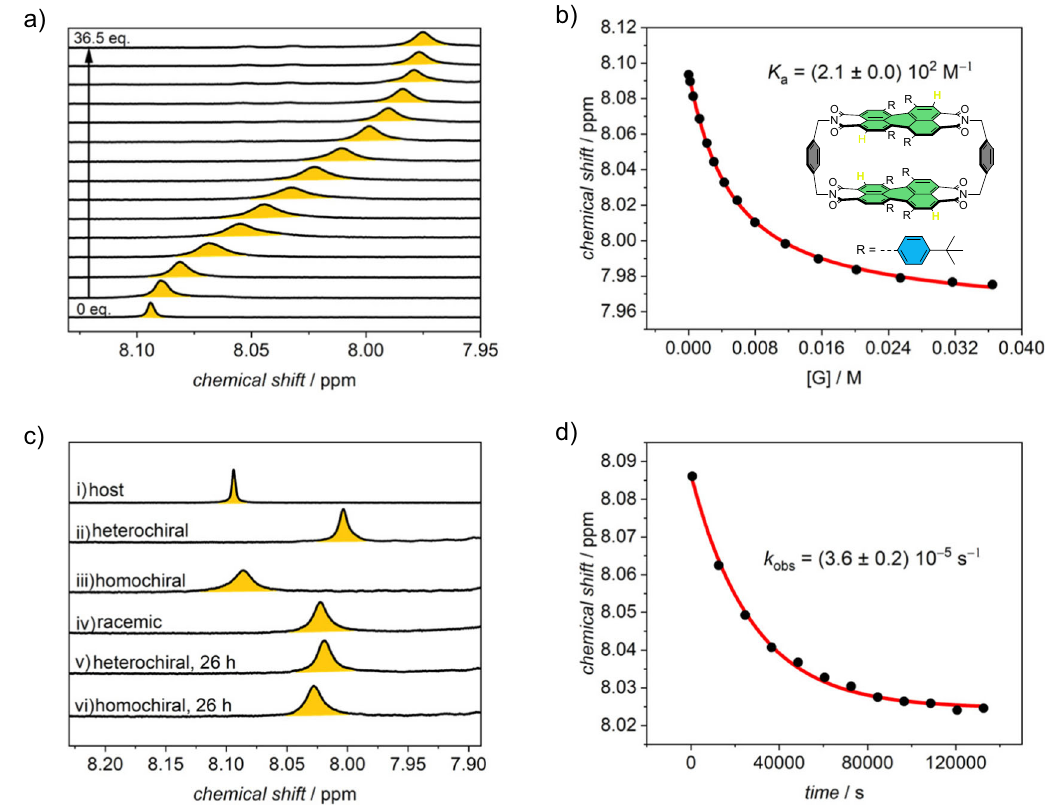
Fig. 4 | Complexation studies with [5]helicene. a Excerpt of 1 H NMR (CCl 4 /MCH- d 14 3:1(v:v), c ( rac - 1 )=1.0×10 − 3 M,295K)titrationexperimentofhost rac - 1 with rac - [5]helicene and ( b ) the nonlinear curve fi t of the obtained chemical shift of PBI ortho proton versus guest concentration according to the 1:1 binding model. c Excerptof 1 HNMRspectra(CCl 4 /MCH- d 14 3:1(v:v), c (host)=1.0×10 ‒ 3 M,295K)of